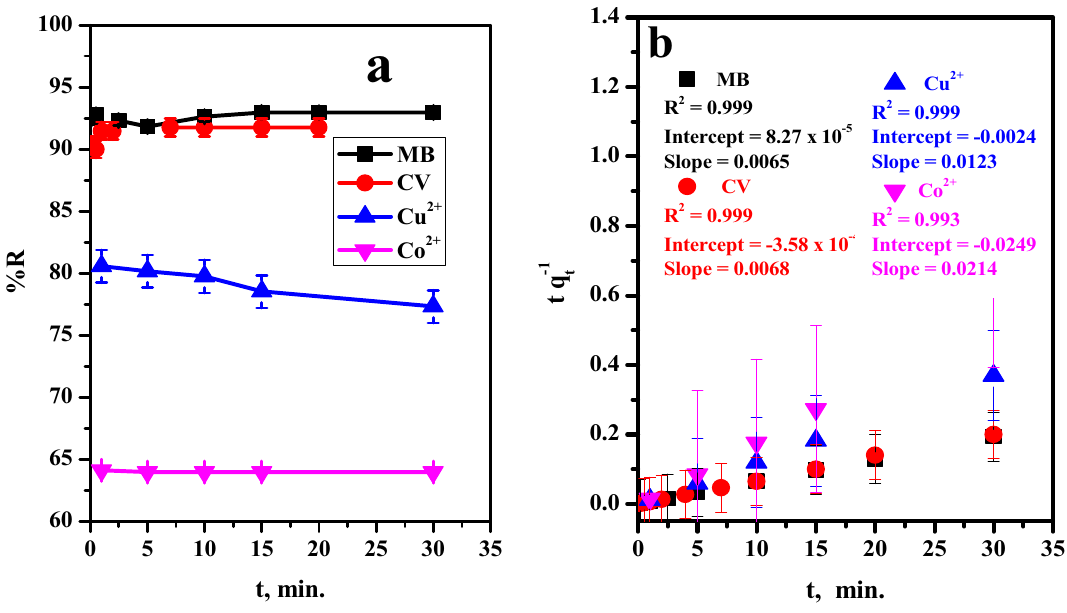
Figure 5. Effect of ( a ) contact time on removal percent, ( b ) Pseudo second-order plot of MB-dye ([[MB] = 20 ppm, Dose = 6 mg, v = 50 ml, pH = 7, T = 30 °C) and CV-dye ([CV] = 20 ppm, Dose = 6 mg, v = 50 ml, pH = 7, T = 30 °C), Cu 2+ ([Cu 2+ ] = 50 mg l −1 , Dose = 2.4 mg, v = 5 ml, pH = 5, T = 25 °C)and Co 2+ ([Co 2+ ] = 50 mg l −1 , Dose = 2.4 mg, v = 5 ml, pH = 6, T = 25 °C) from aqueous